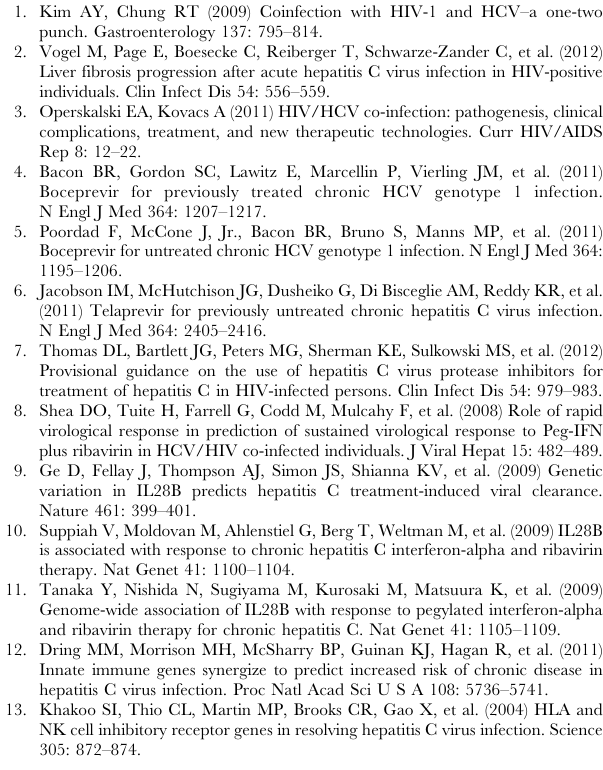
Figure S1 On treatment HCV kinetic response stratified according to innate immune gene risk factors. Kinetic responses are shown for patients with HCV genotypes 1/4 (A) and non-1/4 genotypes (B). Black squares indicate carriage of 1 or no innate immune gene risk factors; Black triangle, carriage of both IL28B-T and KIR2DS3 . Symbols shown mean value and bars show standard error of the mean (SEM). (TIFF)